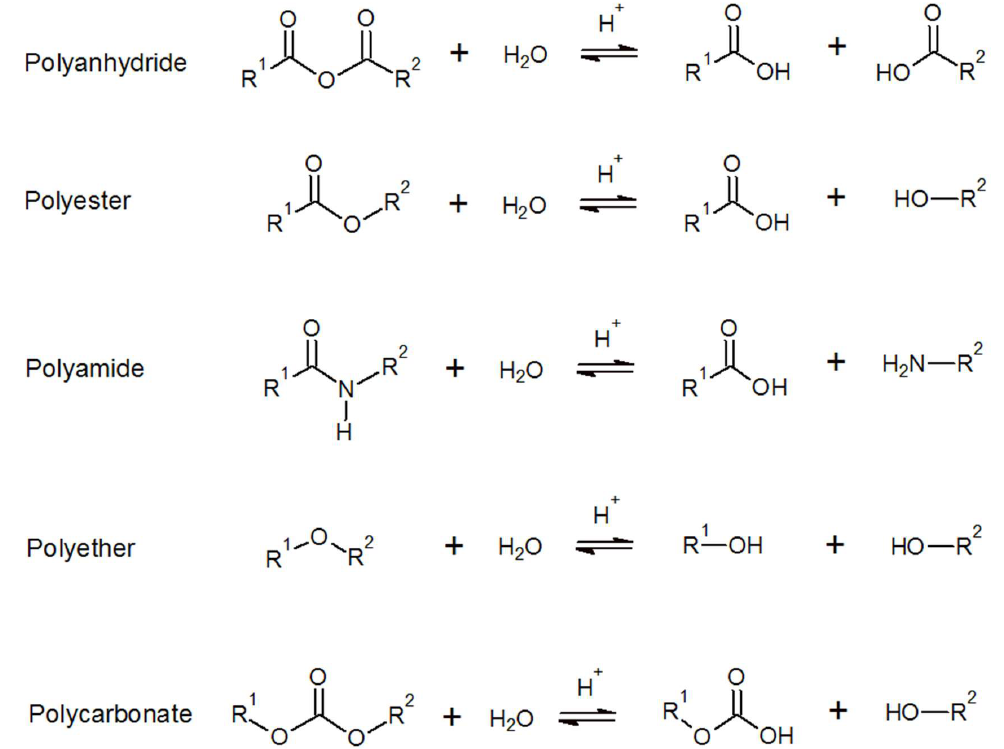
Figure 4. Various hydrolysis reactions [49] .